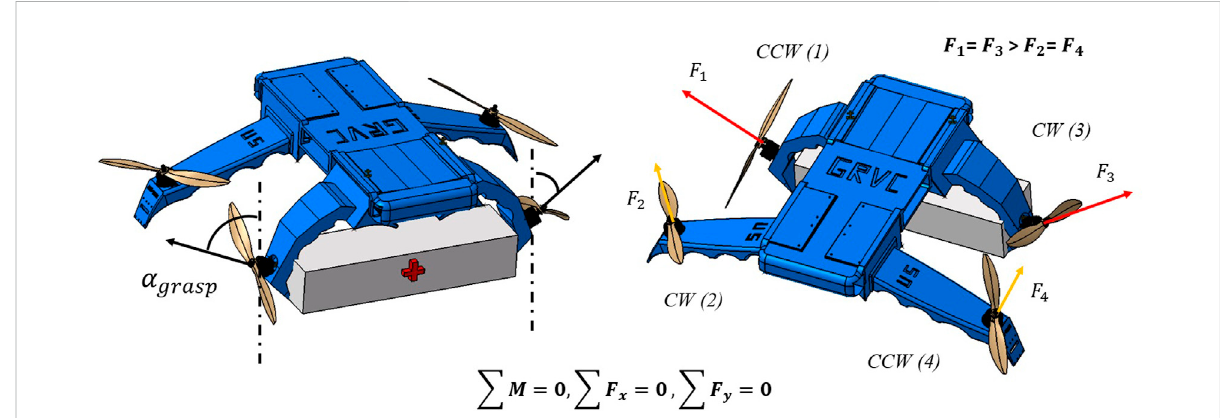
FIGURE 9 Descriptionofthegraspingconceptwith fl exiblearmsinsoftUAVsandde fi nitionofthemaximumangleofgrasping α grasp , max .Thisworkintends to provide insight into the limitations of these angles in fl ight, while the actual grasping maneuver is not studied.